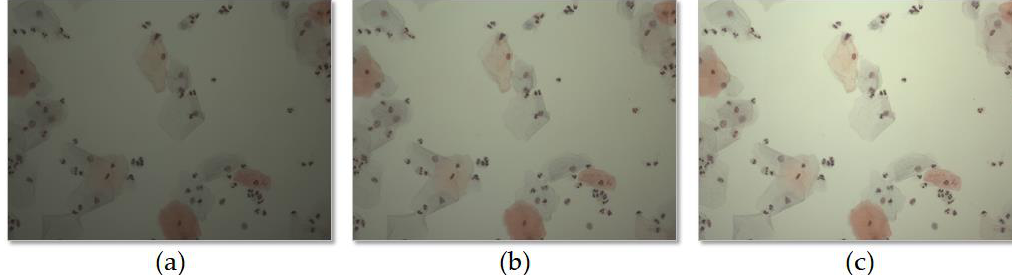
Figure 9. Shading correction results of two previous methods and the proposed method: ( a ) result image corrected by CIDRE method, ( b ) result image corrected by BaSiC method, ( c ) result image corrected by the proposed method, ( d ) ground-truth image, ( e ) intensity profile on dotted line of ( a ), ( f ) intensity profile on dotted line of ( b ), ( g ) intensity profile on dotted line of ( c ) and ( h ) intensity profile for the red channel on dotted line of ( d ).